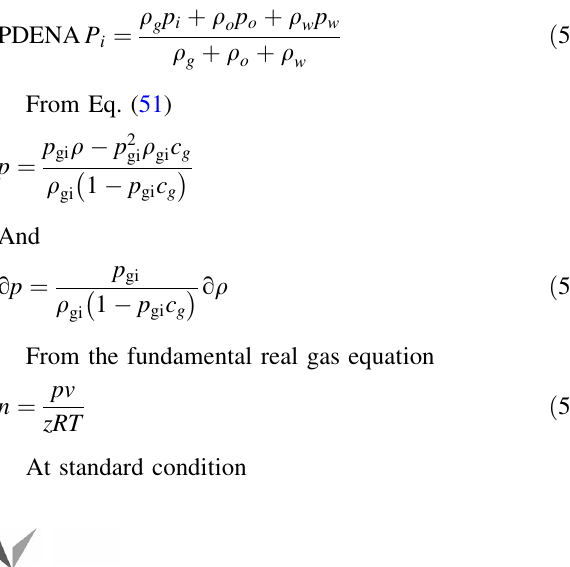
algorithm for compressible fluid such as gas. Bottom-hole flowing or shut-in fluid-phase densities from field, design or synthetic data generated from simulation software with wellbore densities keywords for each phase can be converted to pressure–density equivalent using Eqs. (32) and (51). Pressure equivalent from the fluid-phase densities are then analysed in any of the well test software. Also the density weighted average, PDENA, is used to obtain the pressure–density equivalent for a two or three phase combination. The pressure–density equivalent derived from the densities for all three fluid components such as gas, oil and water is given as